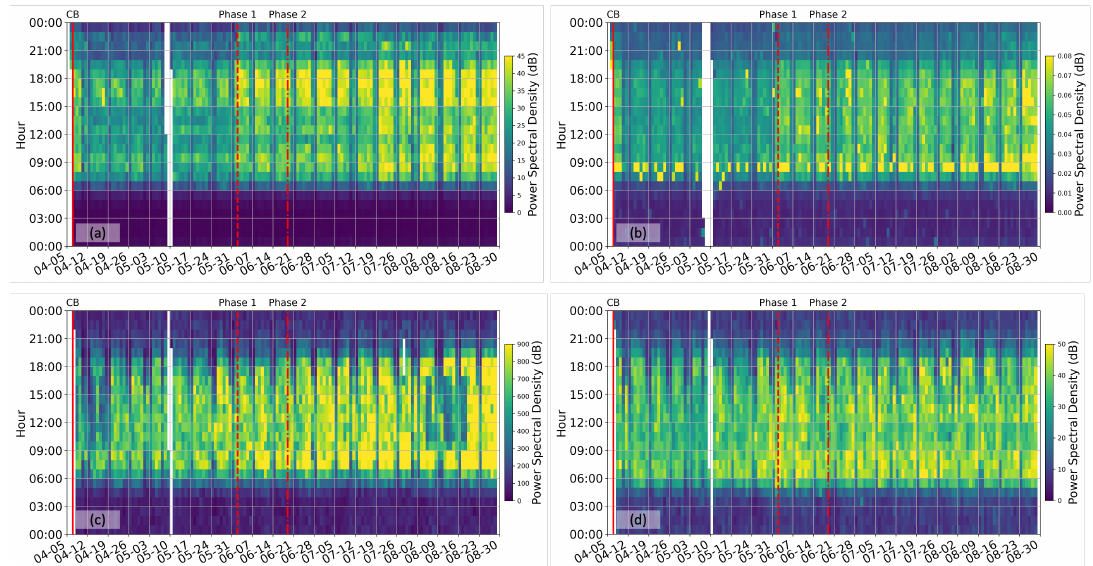
Figure 2. Cumulative power spectral density (PSD) between 1 Hz and 30 Hz at ( a ) NUS hilltop, ( b ) NUS exit, ( c ) West Coast Highway, and ( d ) West Coast Park, respectively. The solid red line denotes the beginning of the Circuit Breaker (CB). The two dashed red lines denote the onset of Phase 1 and Phase 2 opening according to Singapore policy, respectively. The horizontal ticks are days in the calendar year of 2020, and the vertical ticks are hours in local time. The white stripes correspond to time periods when data were